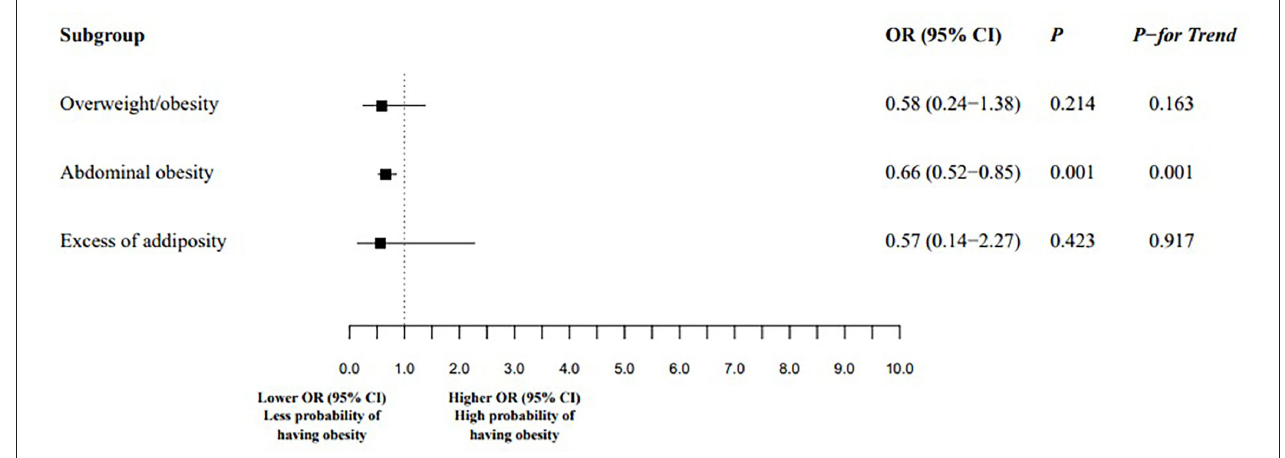
FIGURE 2 | Association between the highest and the lowest quintiles of flavonoids from cocoa-based products (mg/day) intake and obesity. Overweight/obesity was defined by body mass index percentile equal to or above the age- and gender-specific 85th percentile. Abdominal obesity was defined by WC at or above the 90th percentile and/or WHtR equal to or above the 0.5 threshold. Excess of adiposity was defined by %FM and or FMI greater than or equal to the age- and gender-specific 75th percentile. Q, quintiles of flavonoids from cocoa-based products; OR, odds ratio; CI, confidence interval. Statistical analyses were conducted using multilevel mixed-effect logistic regression model. The fixed effects were gender, age, Tanner maturation stage, physical activity, parental education, intake of energy, breakfast cereals, pastries, sugar-sweetened beverages, meat, processed meat, fruits, vegetables, legumes, nuts, and extra olive oil. Municipalities and schools were included as random effects. P -values between Q5 vs. Q1 and P - for trend were obtained using orthogonal contrasts test. P < 0.05 are considered statistically